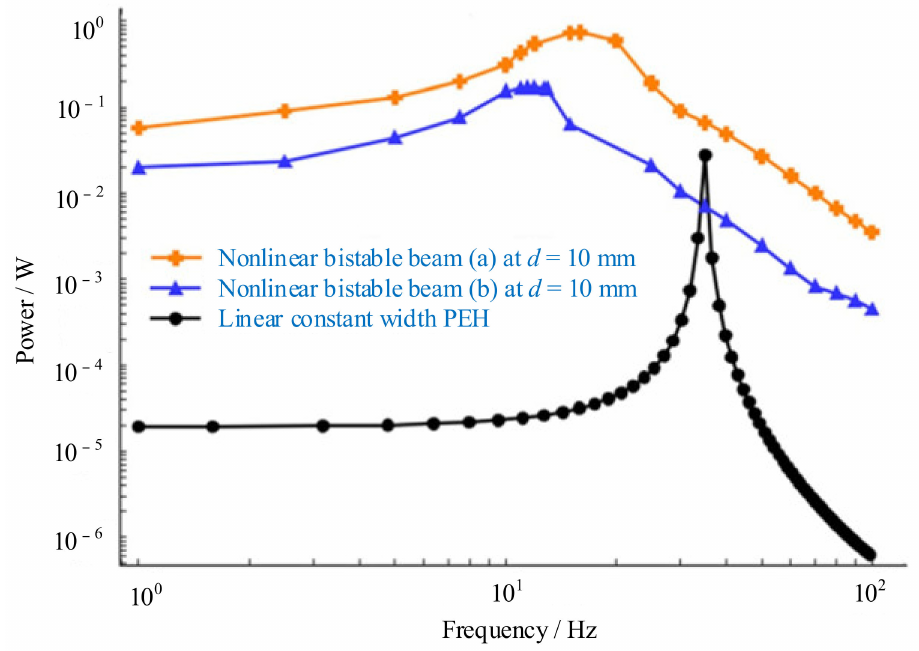
Figure 6. Power generated by bistable and linear harvesters at d = 10 mm (reproduced with permis- sion from [136]; published by Wiley-VCH Verlag GmbH & Co. KGaA, Weinheim,